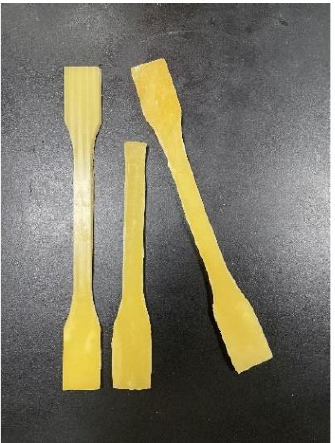
Figure 2. Dumbbell-shaped samples of PU-ER.